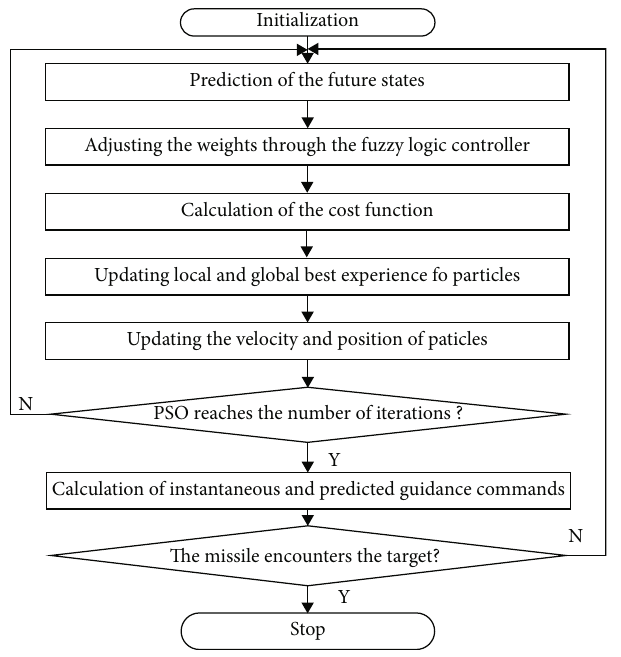
Figure 1: Missile-target engagement geometry.